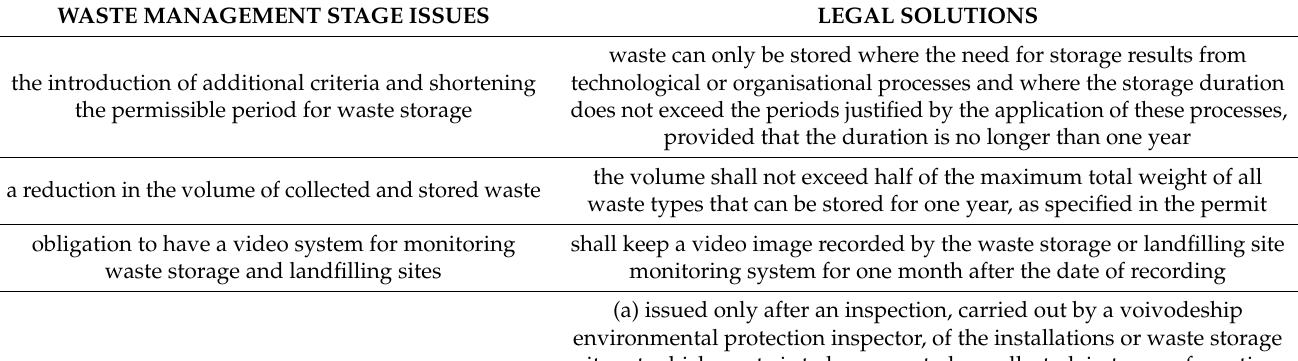
Table 5. Legislative solutions to prevent illegal incinerated